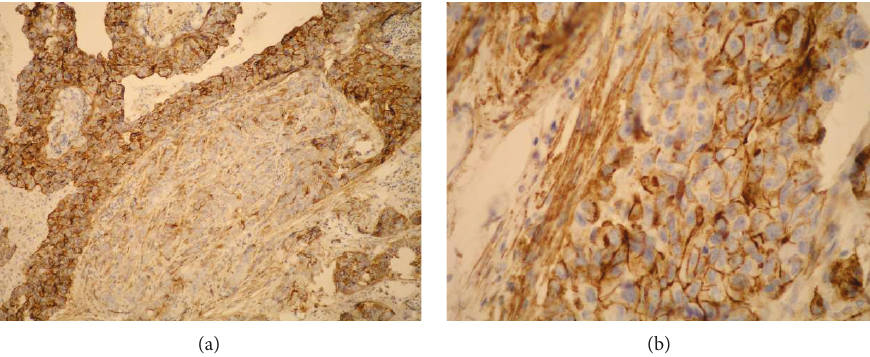
Figure 5: (a) Strong Sdc1 expression in the metastatic epithelium of the ductal carcinoma in the axillary lymph node (IHC, × 100). (b) Strong epithelial (membranous) and stromal Sdc1 expression in the metastasis of the ductal carcinoma in the axillary lymph node (IHC, × 400).